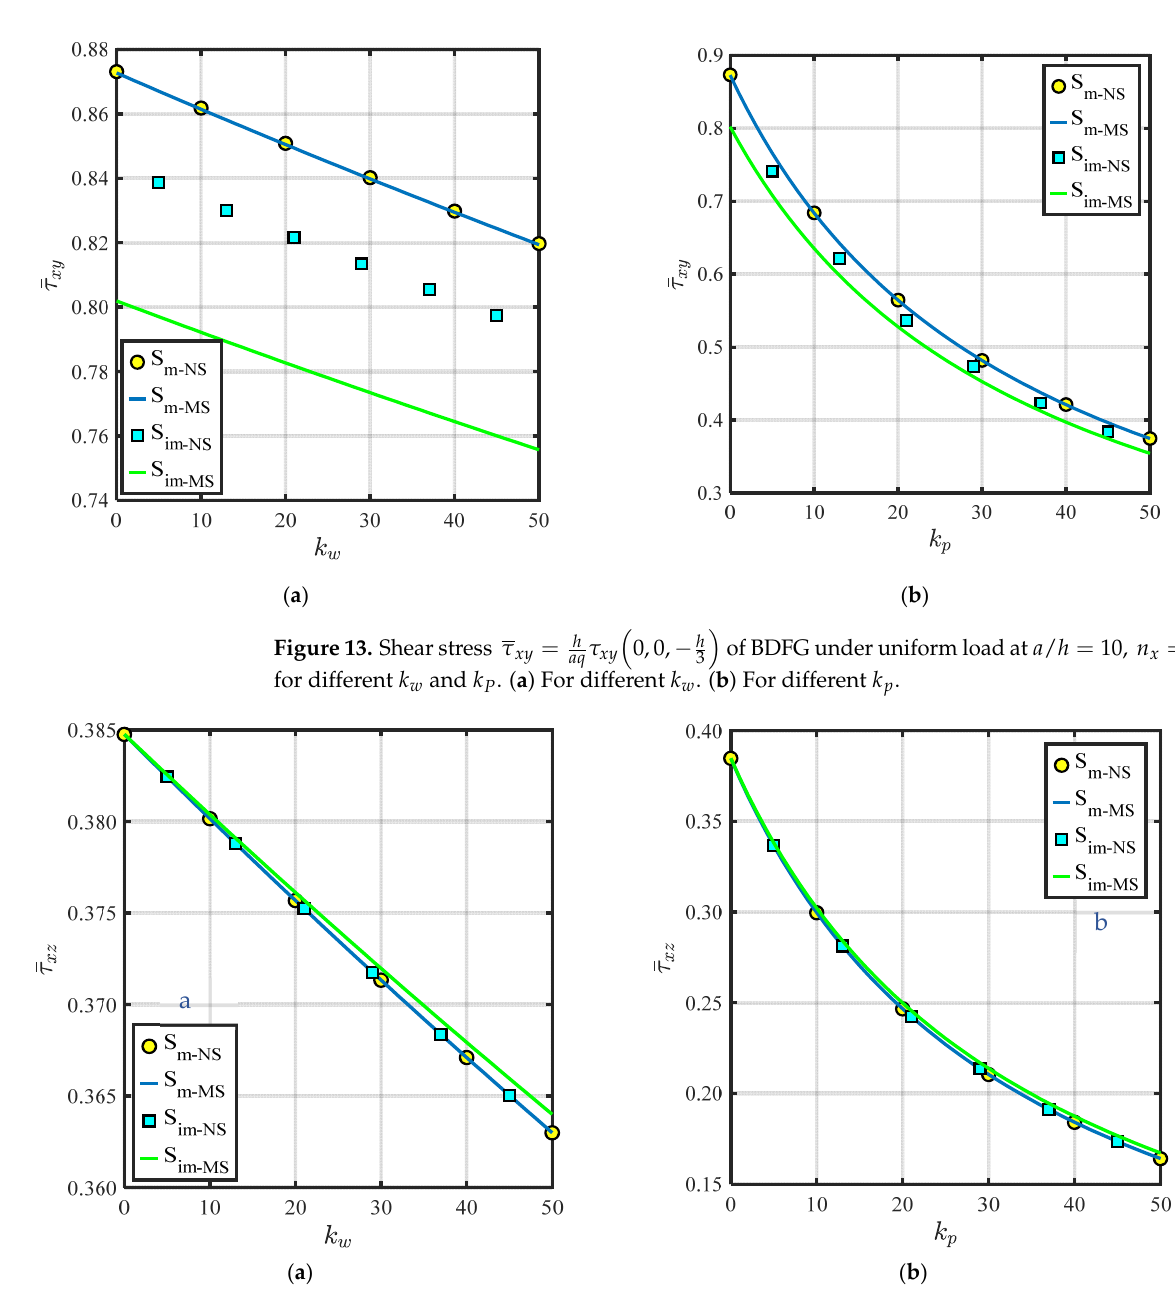
(cid:17) (cid:16) 𝜏 (cid:3051)(cid:3052) (cid:4672)0,0,− (cid:3035) (cid:4673) of BDFG under uniform load at 𝑎 ℎ⁄ = 10,𝑛 (cid:3051) = 𝑛 (cid:3053) = Figure 14. Shear stress 𝜏̅ (cid:3051)(cid:3053) = (cid:3035) Figure 14. Shear stress τ xz = h τ xy 0,0, − h of BDFG under uniform load at a / h = 10, n x = n z = 2 𝜏 (cid:3051)(cid:3052) (cid:4672)0,0,− (cid:3035) (cid:4673) of BDFG under uniform load at 𝑎 ℎ⁄ = 10,𝑛 (cid:3051) = 𝑛 (cid:3053) = Figure 14. Shear stress 𝜏̅ (cid:3051)(cid:3053) = (cid:3035) aq 3 (cid:3028)(cid:3044) (cid:2871) (cid:3028)(cid:3044) (cid:2871) for different k w and k P . Conclusion. ( a ) For different k w . ( b ) For different k p 2 for different 𝑘 (cid:3050) and 𝑘 (cid:3017) . Conclusion. ( a ) For different 𝑘 (cid:3050) . ( b ) For different 𝑘 (cid:3043) . 2 for different 𝑘 (cid:3050) and 𝑘 (cid:3017) . Conclusion. ( a ) For different 𝑘 (cid:3050) . ( b ) For different 𝑘 (cid:3043) .